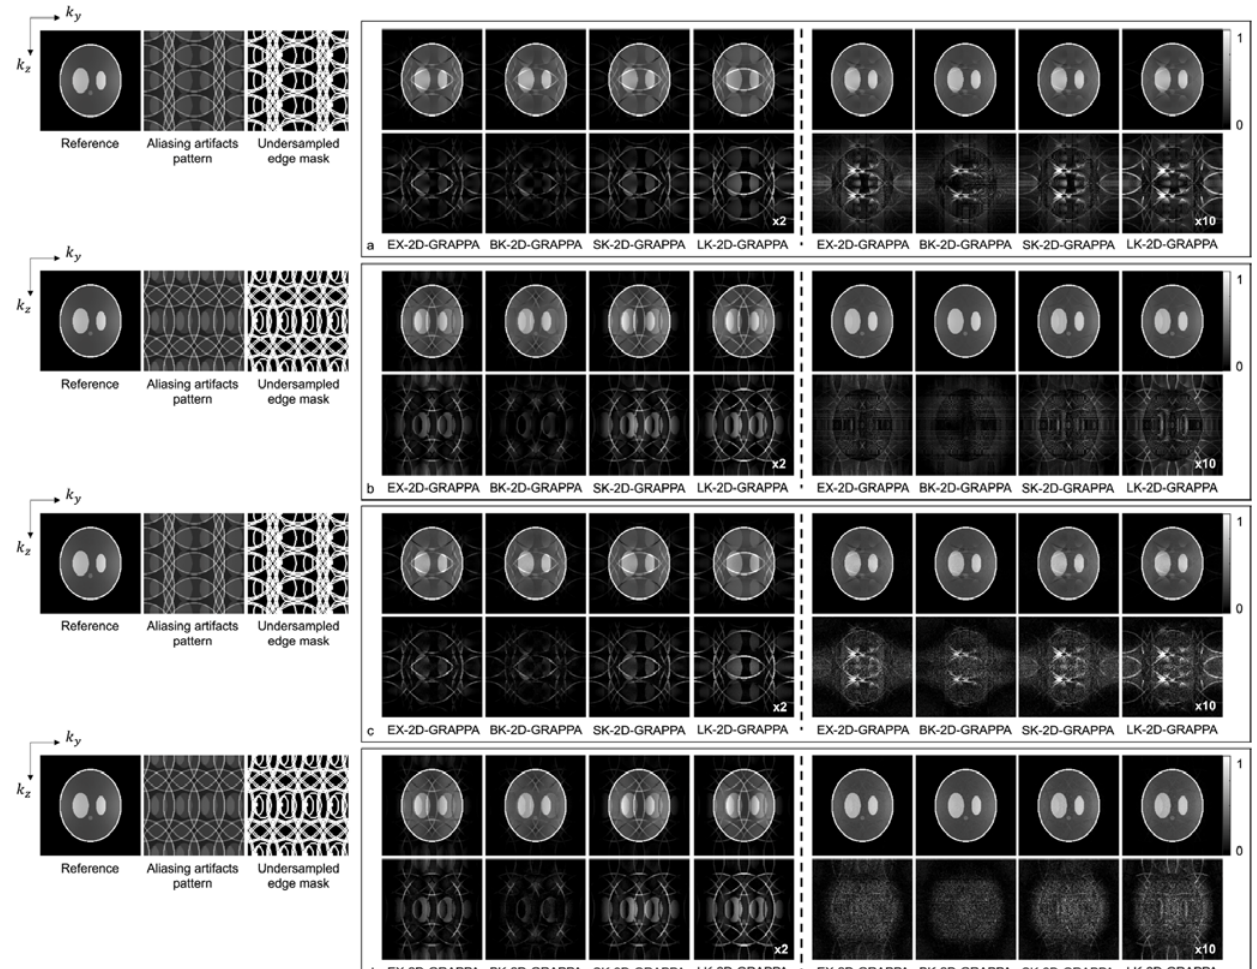
Figure 7. The reconstruction results of 2D-GRAPPA algorithms for simulation data with AF = 8. ( a , b ) and ( c , d ) were reconstructed from noise-free and noise-added data, respectively. Images in ( a , c ) were obtained when k z direction was more accelerated (2 × 4), and images in ( b , d ) were obtained when k y direction was more accelerated (4 × 2). Columns 1–4: basis kernel. Columns 5–8: expanded kernel.